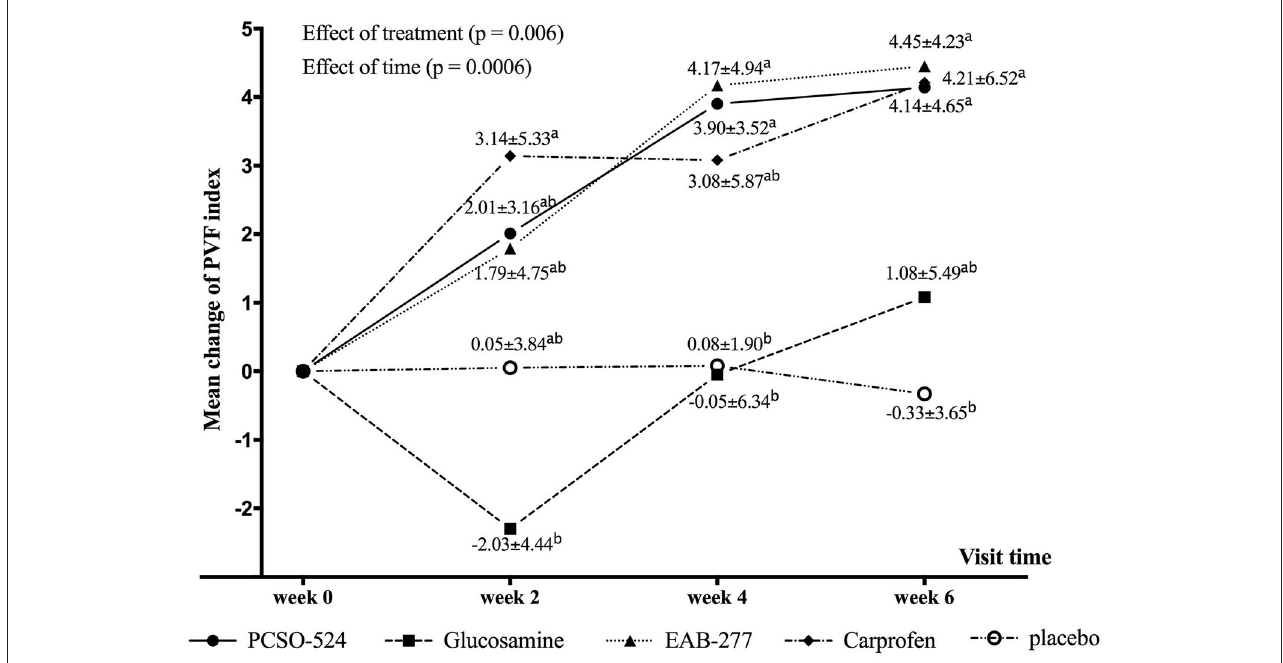
FIGURE1 Graphical representation of the mean ( ± standard deviation) change from baseline in PVF for each group during the study period. Different superscripts (a, b) indicate significant differences between groups for change in PVF.